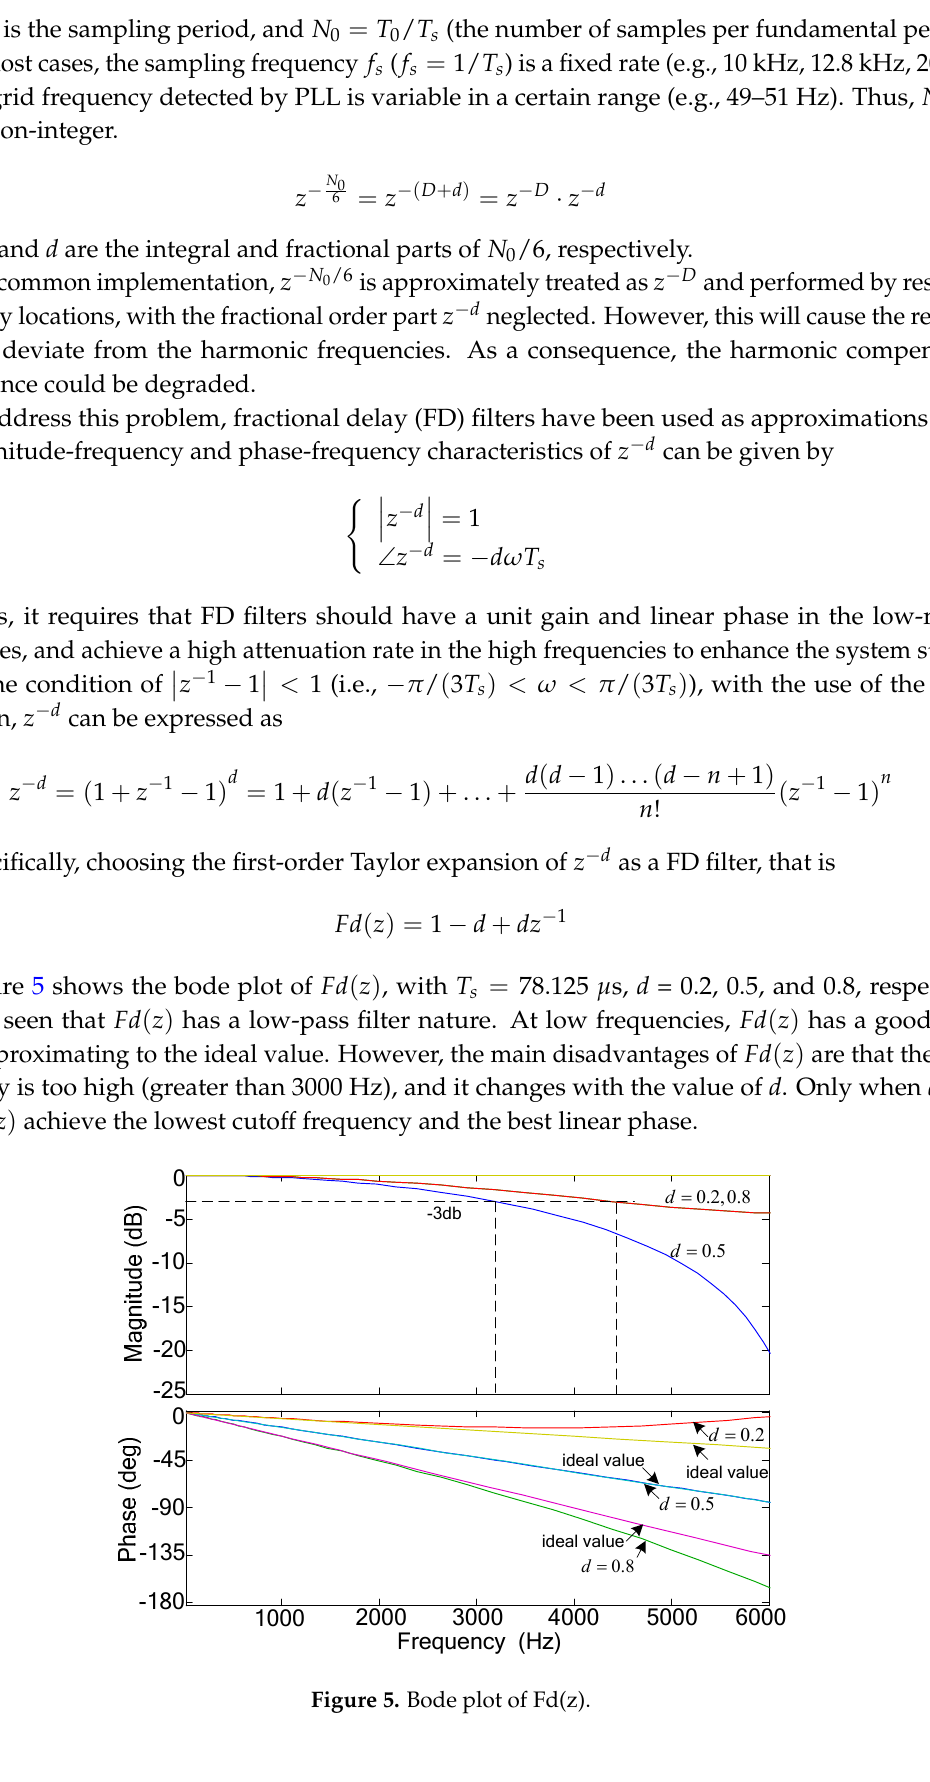
( ) P z  ( ) f G z Figure 6. Block diagram of harmonic current tracking control. In Figure 6, P(z) is the plant of the current control. According to (1) and (2), its expression in continuous domain can be obtained as